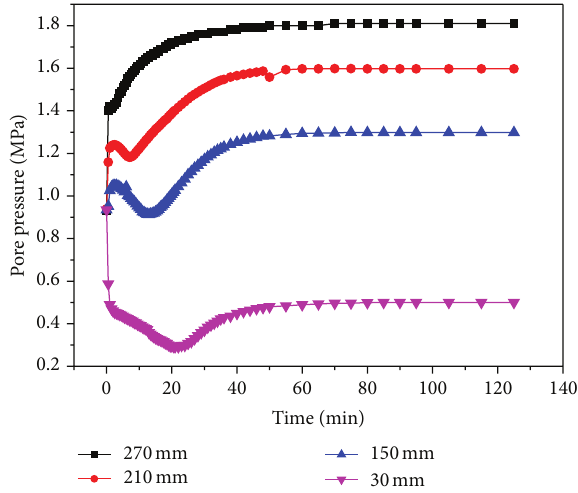
Figure 17: The change of pore pressure during CO 2 -ECBM at 1.8